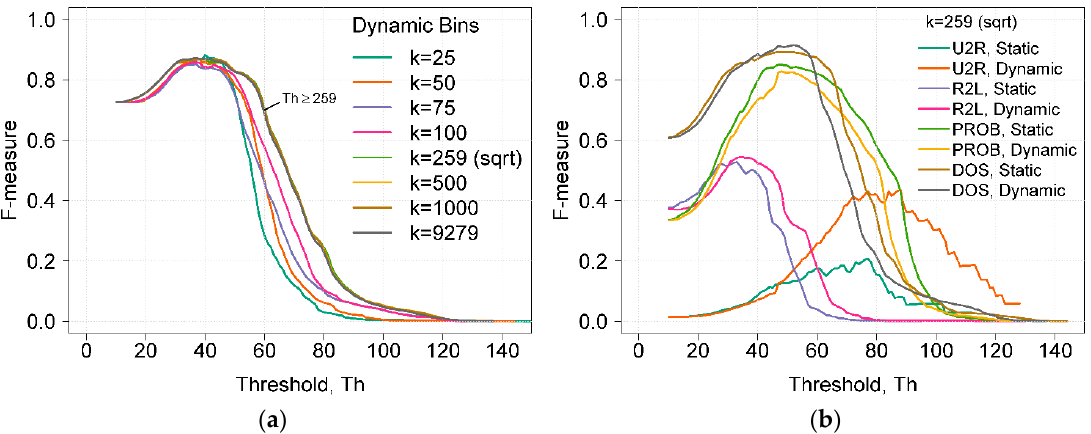
Figure 3. ( a ) Dependence of the F-measure on the detection threshold Th using dynamic bins and different numbers of bins k . ( b ) Comparison of F-measure results obtained by using static and dynamic histogram construction methods.